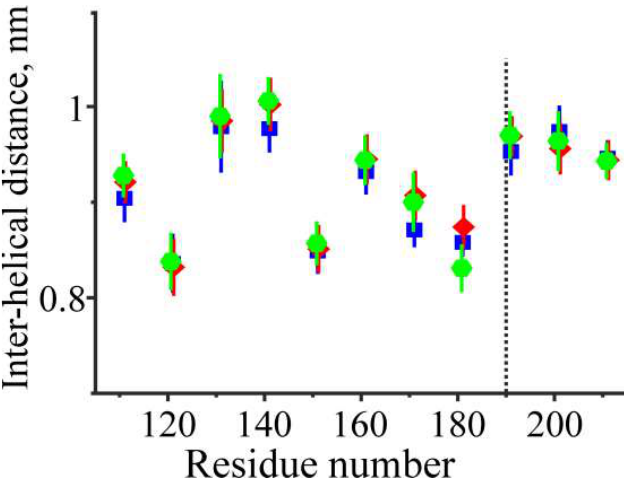
Figure 4. The distance between the two α-helices of the Tpm coiled-coil at different locations along the middle part of the Tpm molecule (mean ± S.D.) were obtained during MD simulation of three Tpm models at 27 °C. Blue squares, red diamonds and green hexagons correspond to uncross-linked, cross-linked and C190A Tpm, respectively. See section 4 for further details of the analysis.